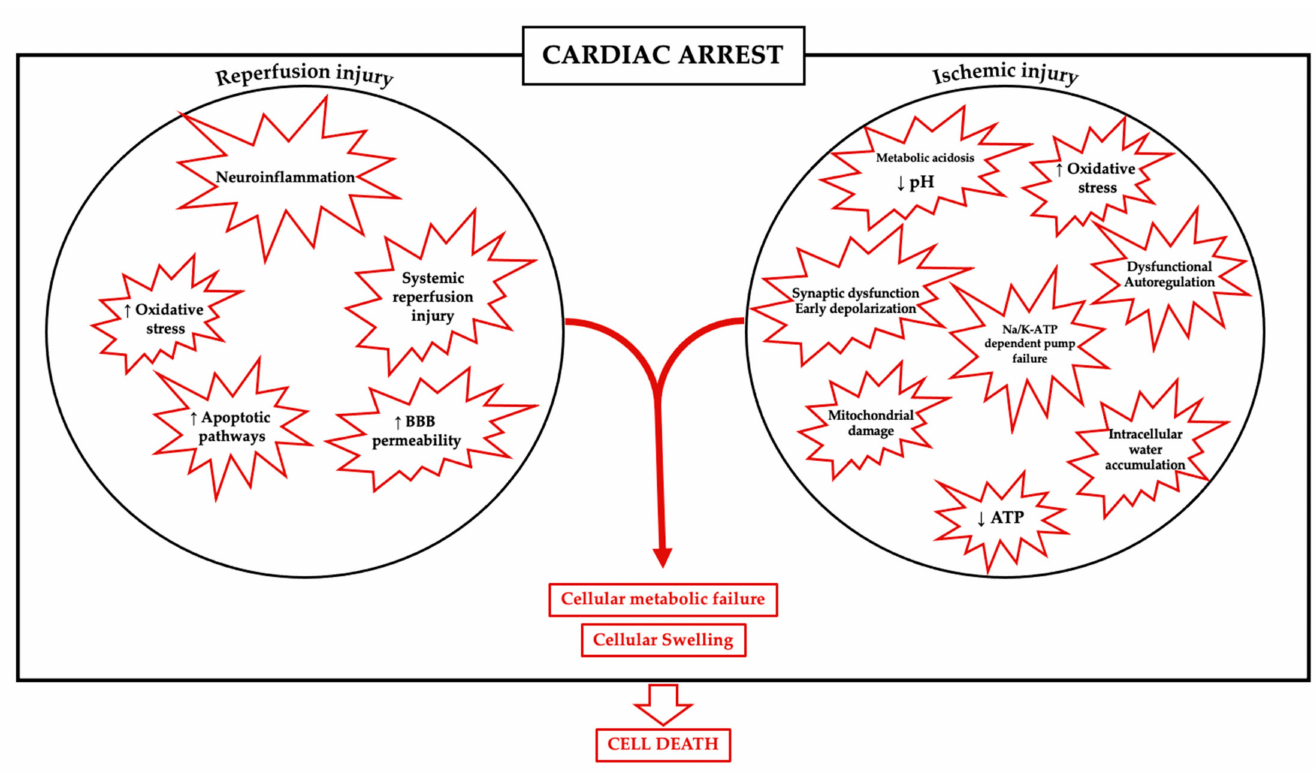
Figure 1. Mechanisms involved in brain injury after